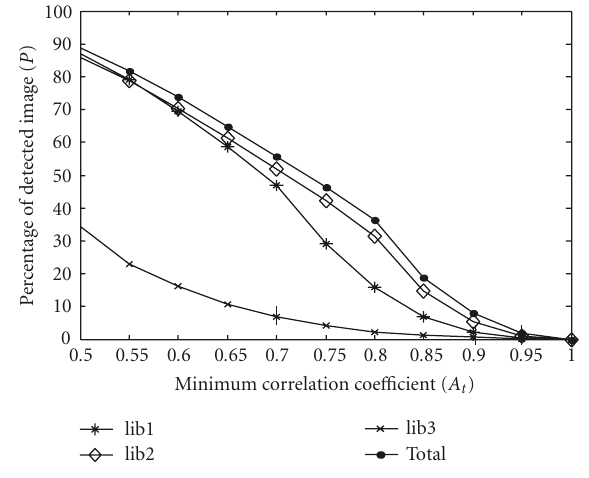
Figure 9: Relationship between the correlation values and percent- age of detected image ( P ) when maximum separation bands are used in the detection. Band used are (2, 10, 18, 26).